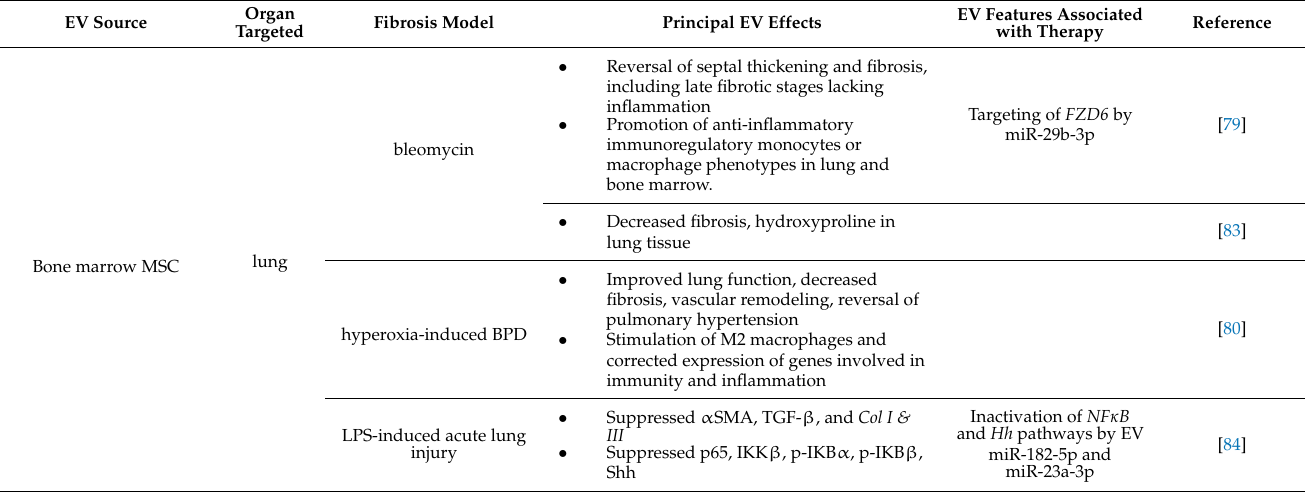
Table 2. Anti-fibrotic properties and actions of stem cell EVs. Principal EV